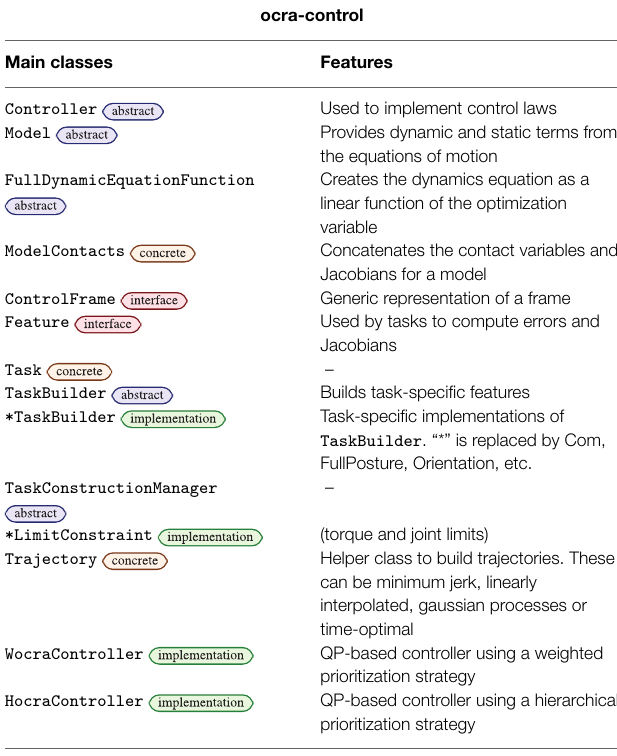
TABLE 7 | Main classes composing the ocra-icub